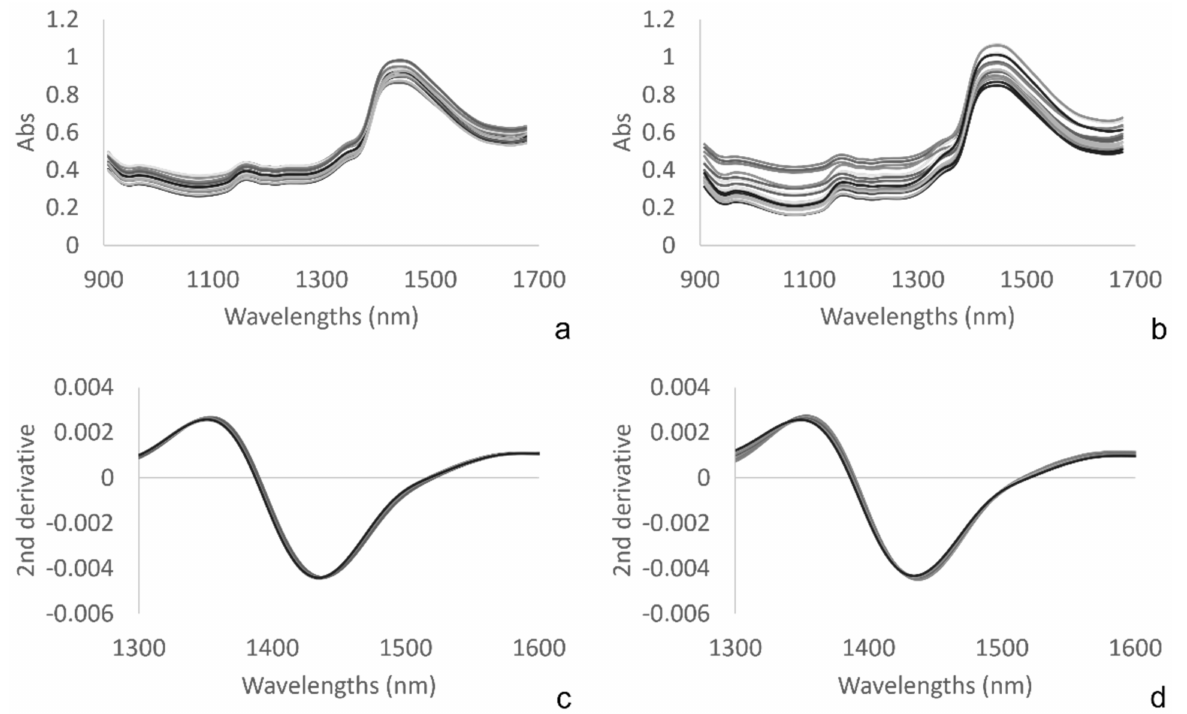
Figure 4. Averaged raw NIR spectra of the packed rocket salad samples of Trial 1 ( a ) and 2 ( b ) and